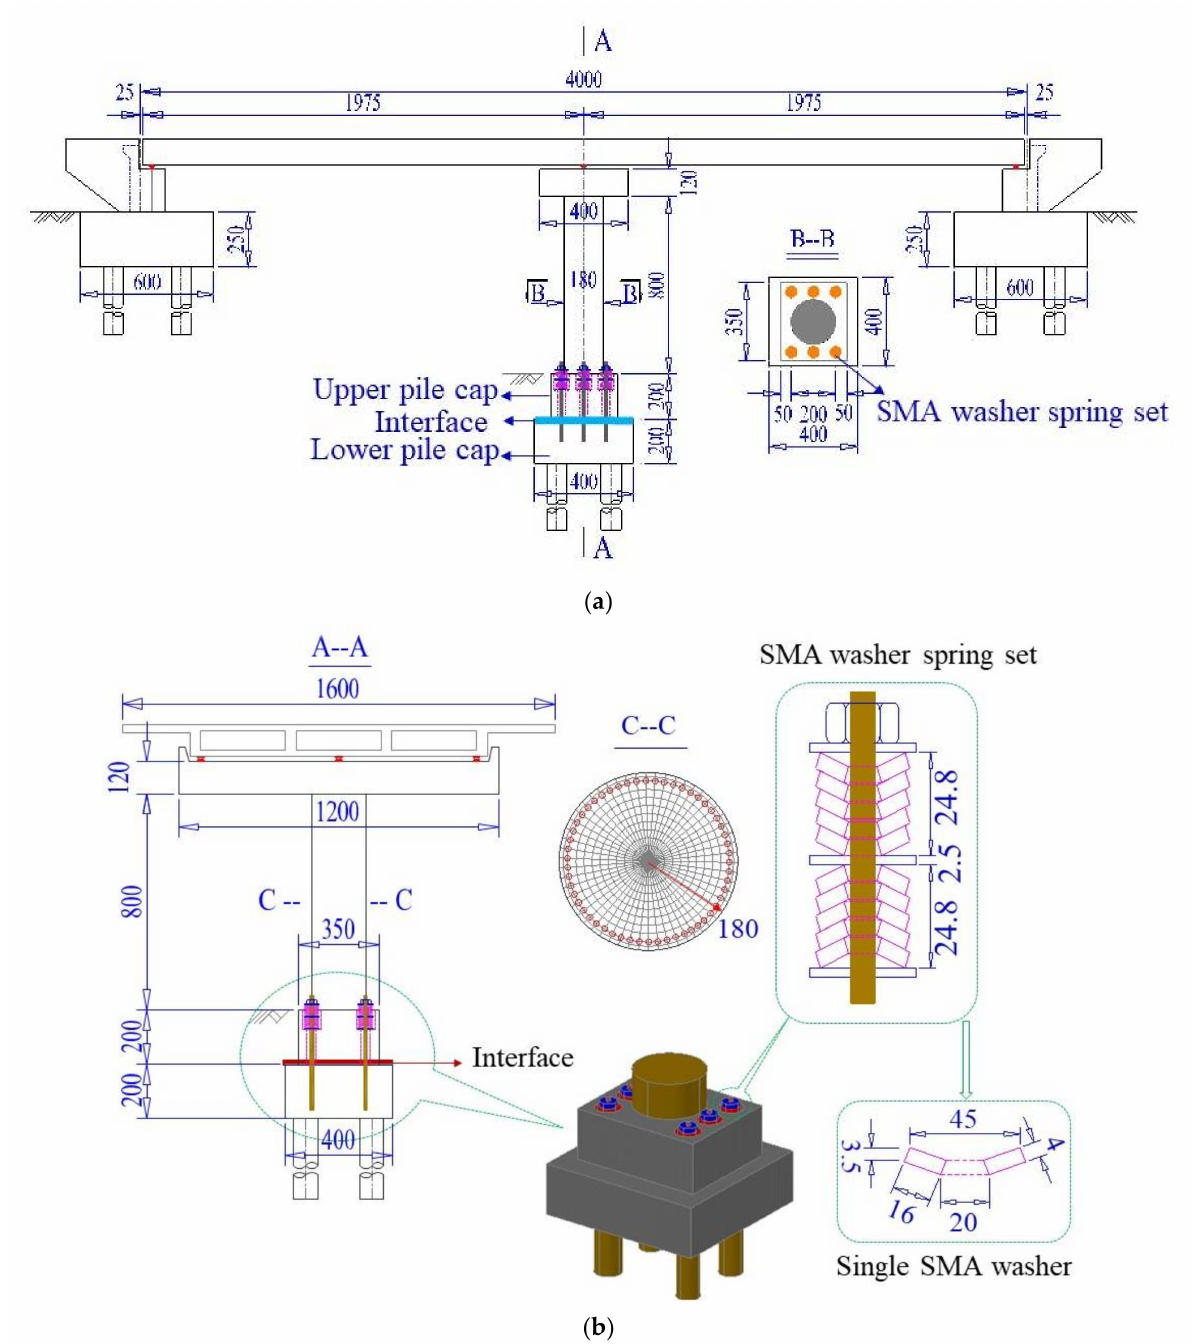
Figure 1. Configuration of the resilient bridge with ECC-reinforced rocking pier (Unit: cm). ( a ) Elevation; ( b ) Layout diagram of the SMA washer spring